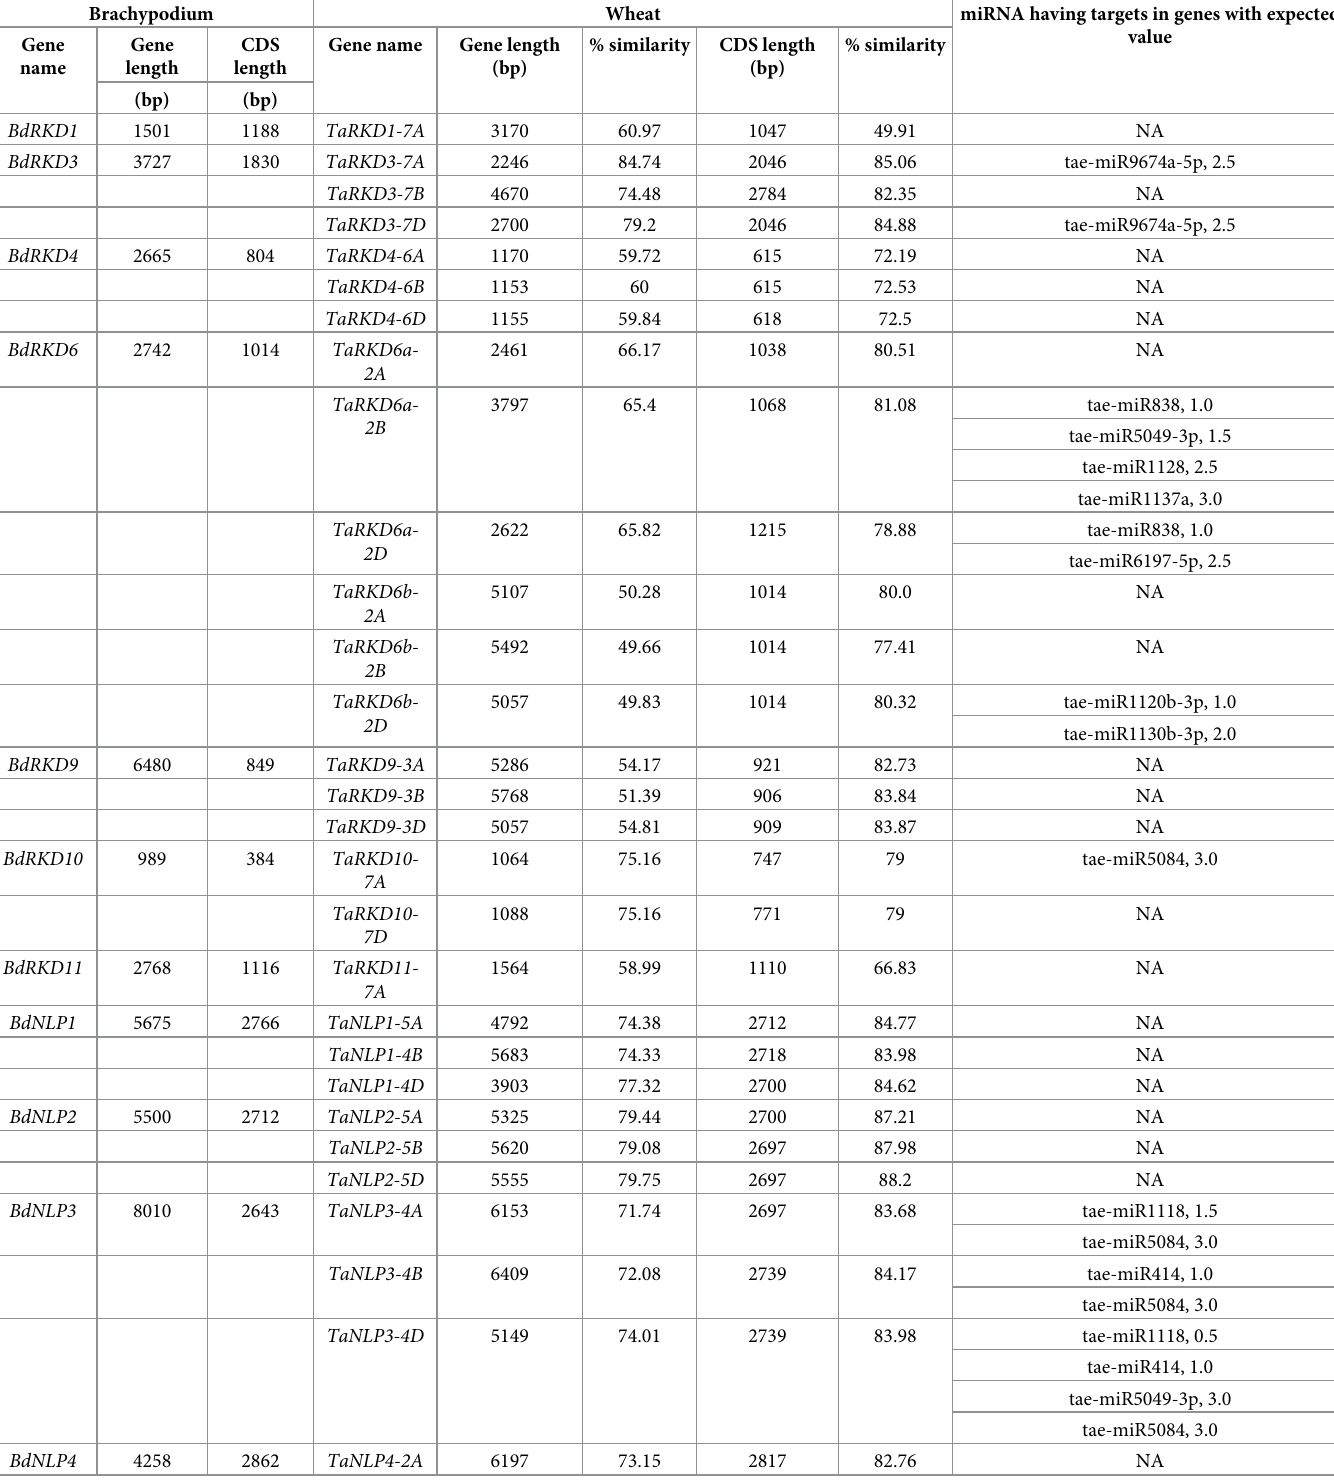
Table 2. Details of CDSs and gene sequences for Brachypodium and wheat along with their percent similarity. RWP-RK wheat genes with targets for miRNAs are also shown. Brachypodium Wheat miRNA having targets in genes with expected